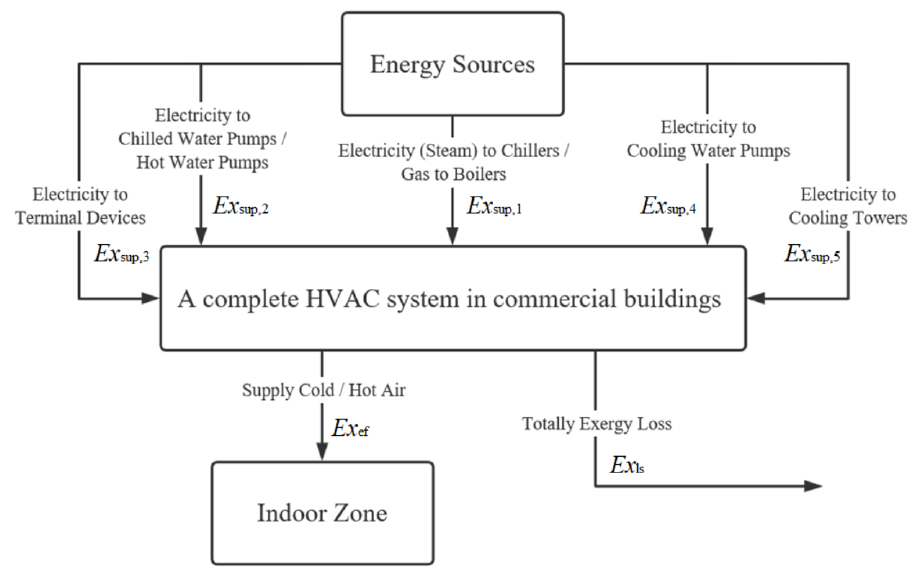
Figure 3. Black-box exergy flux model of a typical HVAC system.